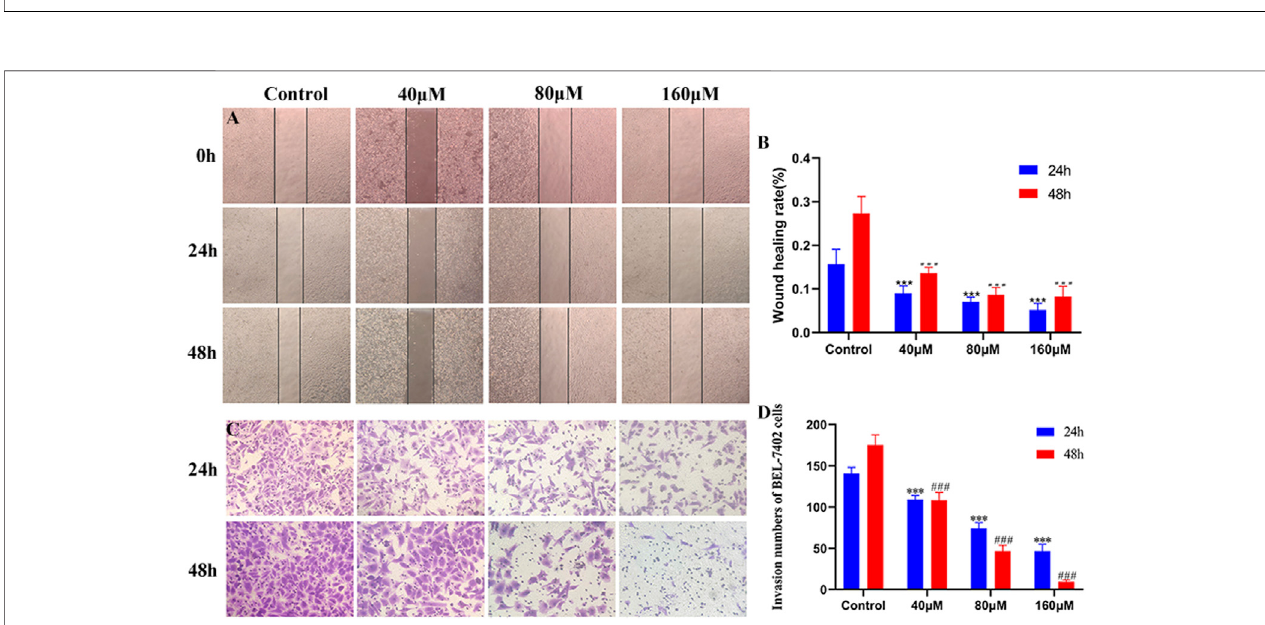
FIGURE2 | Inhibition ofmigrationand invasion ofBEL-7402cells at different concentrationsofmethyl gallate (MG). (A) Representative images ofwound healing in BEL-7402cells treatedwithMG. (B) Quantitation ofBEL-742cells migration. (C) Transwell cellinvasion in BEL-7402 cells treated withMG. (D) Quantitation ofBEL-742 cell invasion. Data were derived from at least three independent experiments. Data are presented as the mean ± standard deviation. *, # p < 0.05, **, ## p < 0.01 and ***, ### p < 0.001 vs. control.